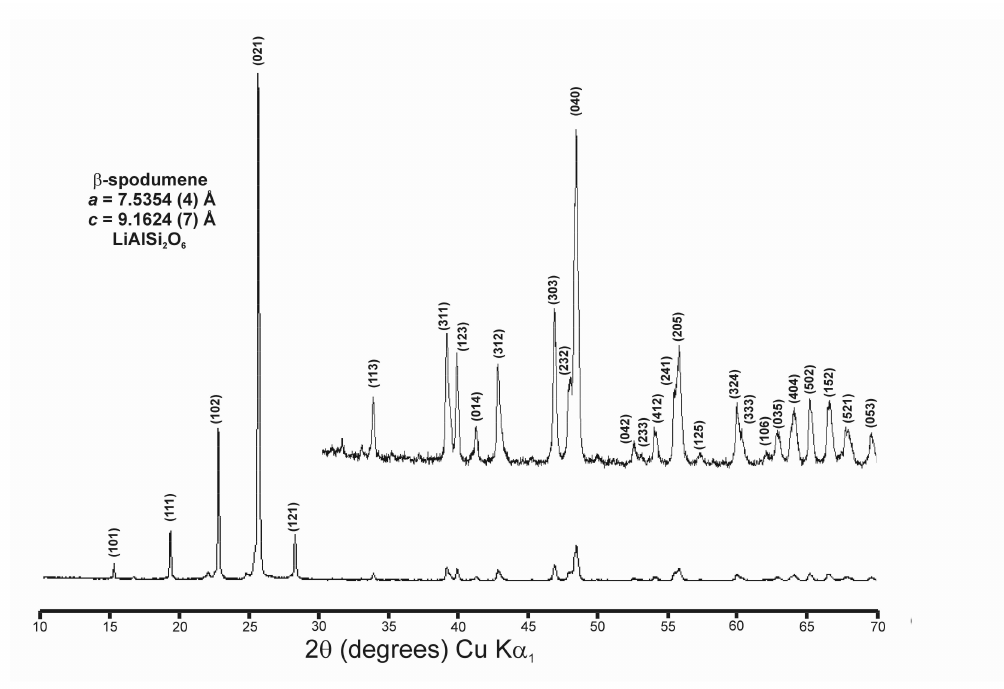
Figure A7. Powder XRD pattern of LiAlSi 2 O 6 β -spodumene with composition x = 0.333 (Si/Al = 2/1) in the solid solution series, with a = b = 7.5354 (4) Å, c = 9.1769 (7), and α = β = γ =90 ◦ , with (hkl) peaks from the P 4 3 2 1 2 space group symmetry [23,24], synthesized at 1200 ◦ C, 1 atm, with cell parameters very similar to file CC 14232 in ICSD database, with a = b = 7.534 (5) Å, c = 9.158 (9) Å, and α = β = γ = 90 ◦ .